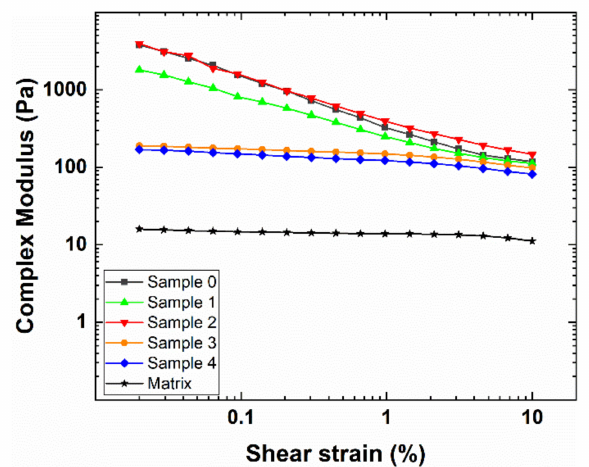
Figure 2. Dependence of the complex modulus of the tested samples upon the applied strain. The rheological response of the pure matrix is reported in the figure inset for